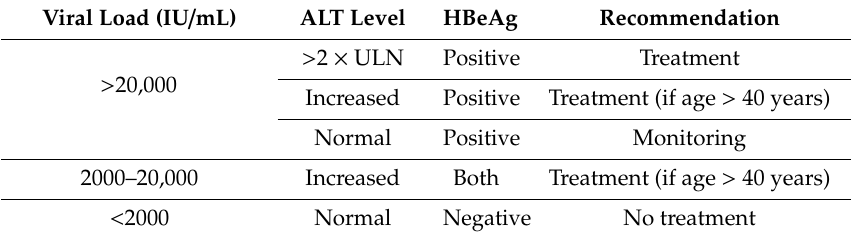
Table 2. AASLD treatment indications for chronic HBV-infected